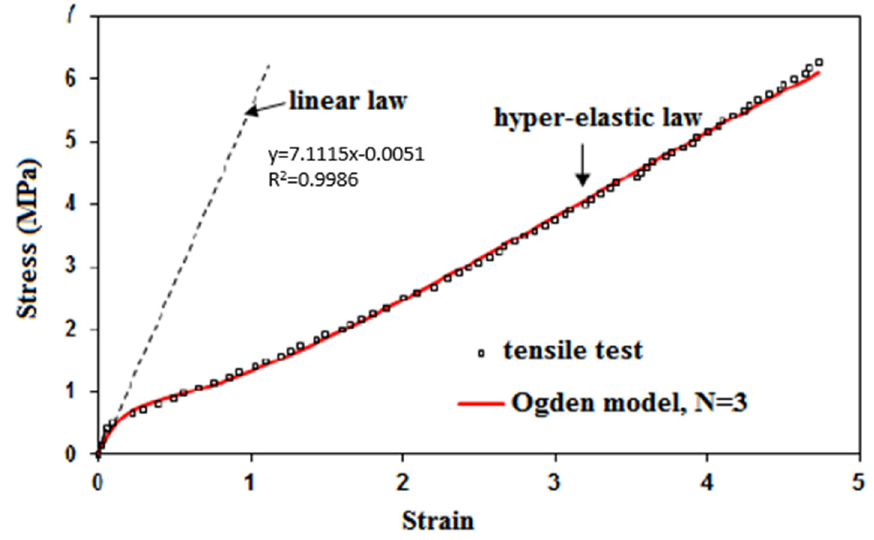
Figure 10. Tensile behavior of cold polymerized adhesive ELASTOGLUE 2000. Table 3. Coefficients of thermal expansion (CTE) of the assembly constitutive materials.